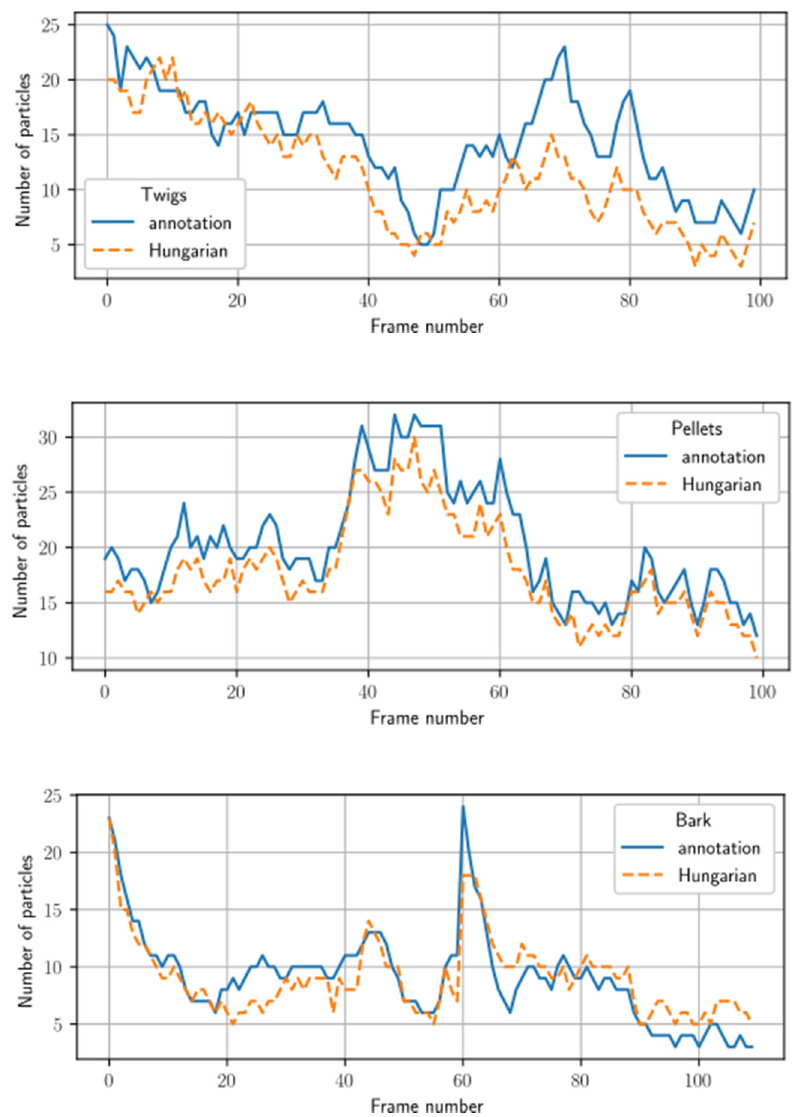
Figure 9. Blind comparison of the Hungarian algorithm-based tracker. The number of firebrands in each frame shows the number of firebrands tracked from the previous frame.